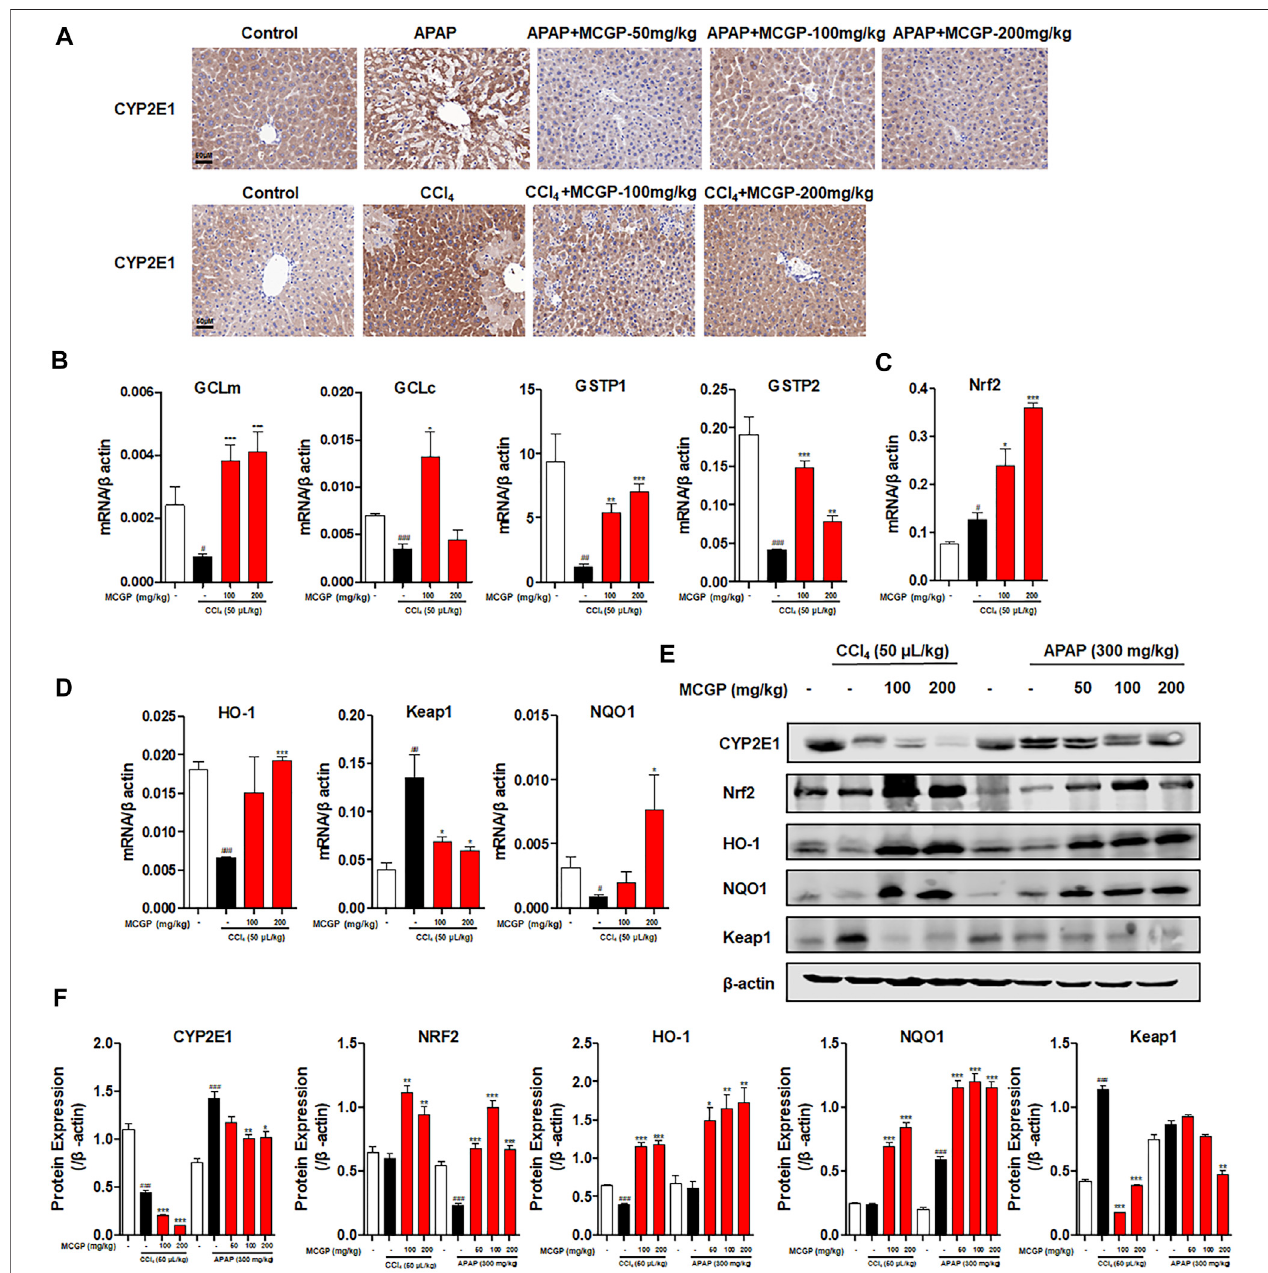
FIGURE 6 | MCGP inhibited CYP2E1 and activated the NRF2/HO-1 signaling pathway in APAP-/CCl 4 -intoxicated mice. (A) Hepatic CYP2E1 immunohistochemical staining of each group in APAP- or CCl 4 -intoxicated mice. (B-D) Transcription level of GClm, GCLc, GSTP1, NRF2, HO-1, Keap1, and NQO1 of each group in CCl 4 -intoxicated mice. (E,F) The protein expression of CYP2E1, Nrf2, HO-1, NQO1, and Keap1 in liver tissues from the APAP or CCl 4 groups (E) . The β - actinwasusedasaninvariantcontrolforequalloading,followedbytheintegrityopticaldensityanalysesofeachblot (F) .Datawerepresentedasthemean±SEM(n = 3). # p < 0.05, ## p < 0.01, ### p < 0.001 vs control, * p < 0.05, ** p < 0.01, *** p < 0.001 vs